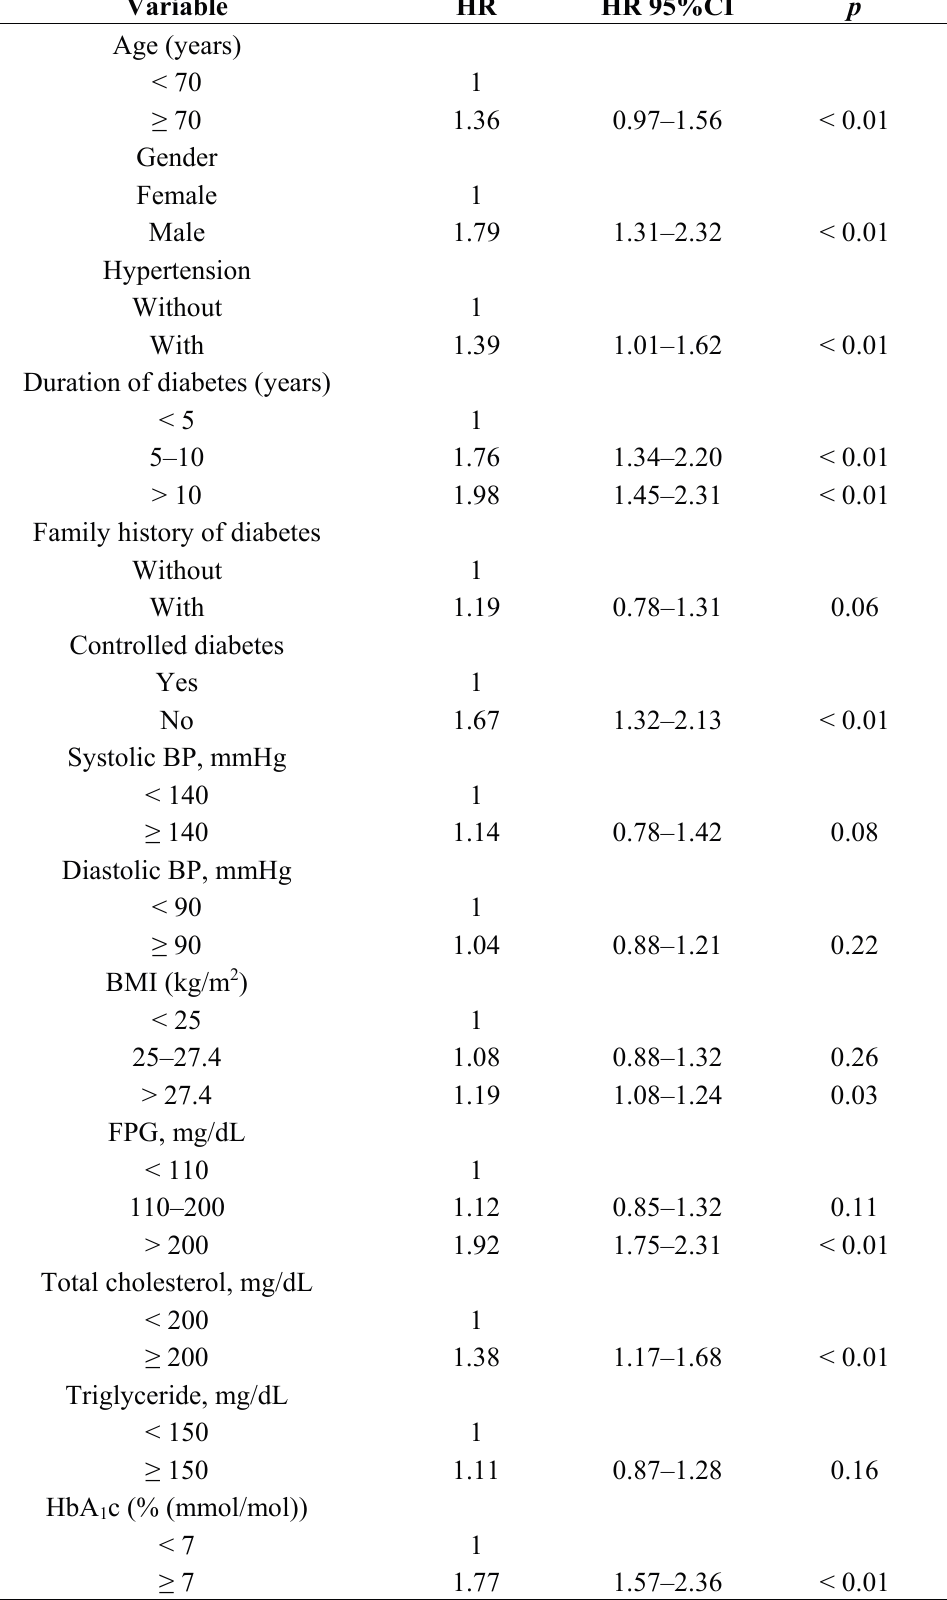
Table 3. Hazard ratios of the factors associated with onset of DR.